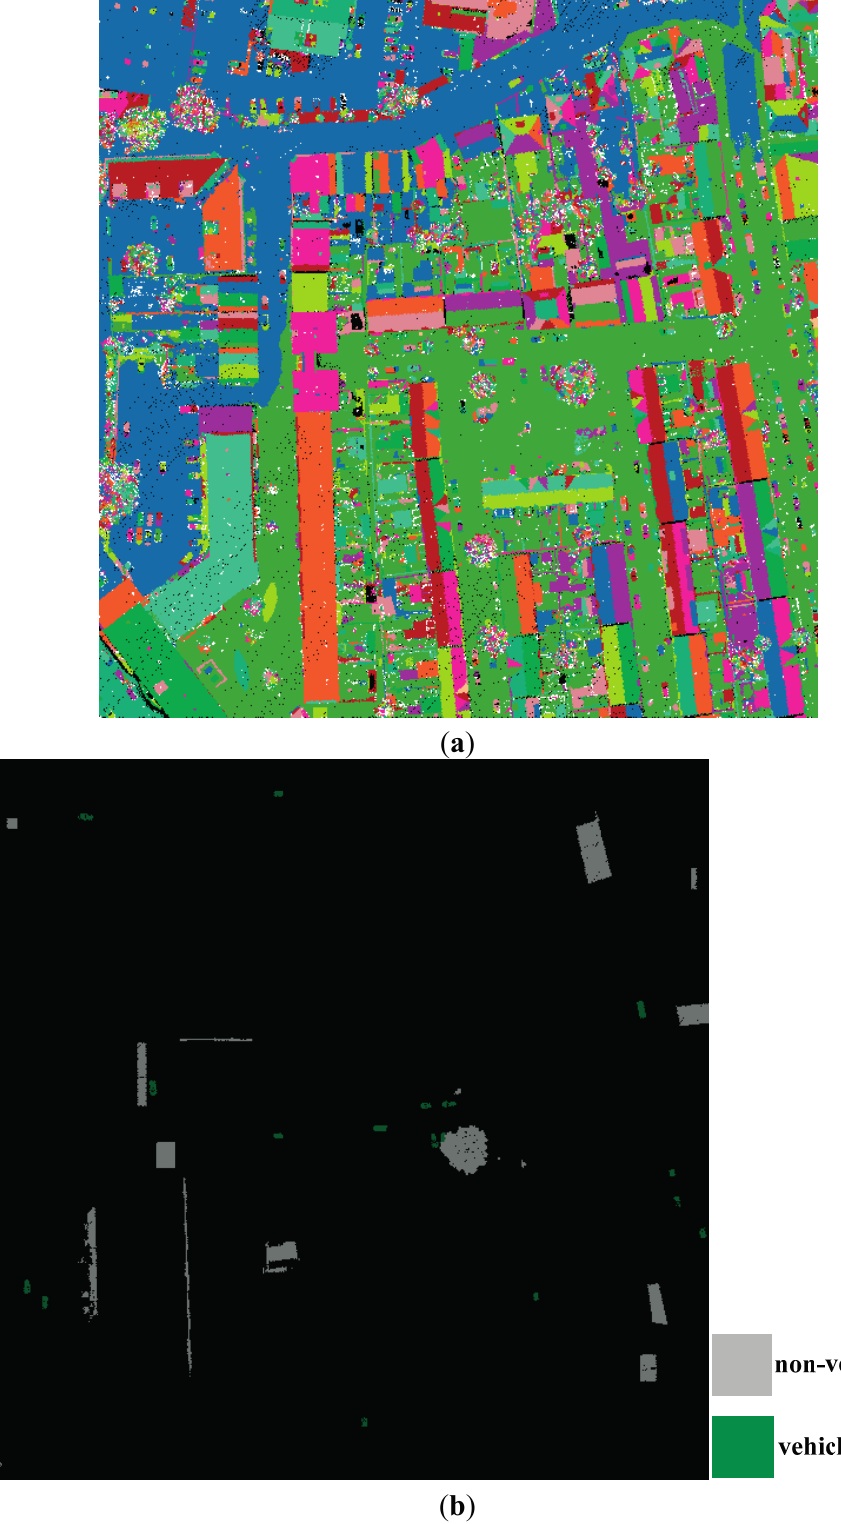
Figure 7. The vehicles extracted by the mean-shift-based method. ( a ) Segmented point cloud, colored by label number. ( b ) Training samples. ( c ) Classification results. ( d ) The extracted vehicles. Note that each vehicle is represented as a rectangle, and the corresponding rectangle is drawn with a random color in